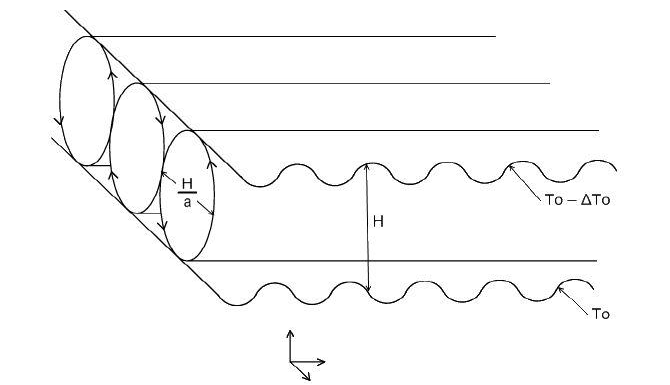
Figure 5. Convective flow above the heated surface.